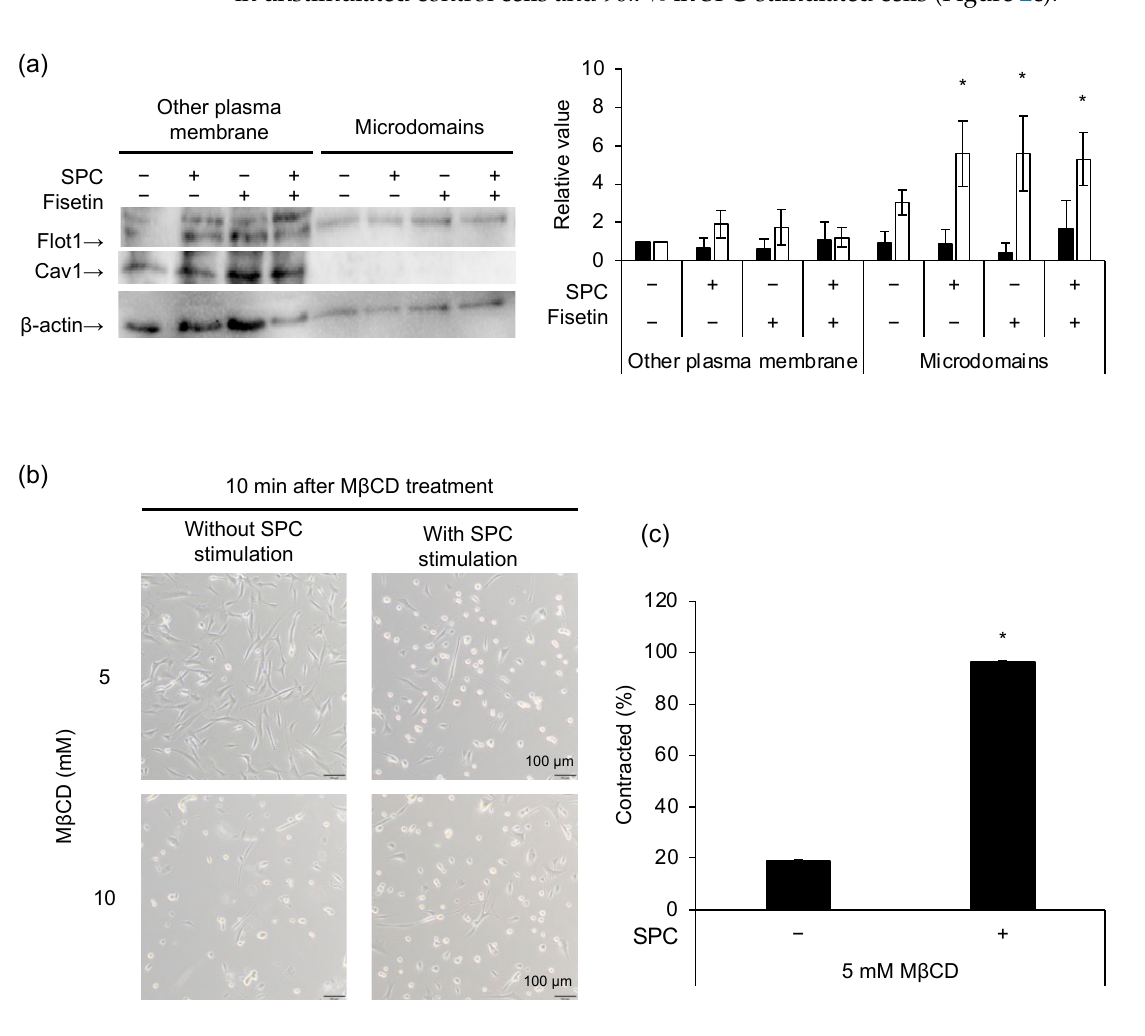
Figure 2. Analysis of sphingosylphosphorylcholine (SPC) and microdomain involvement in SPC- induced contractions of human coronary artery smooth muscle cells (HCASMCs). ( a ) Expression levels of the microdomain markers flotillin-1 (Flot1) and caveolin-1 (Cav1). Black and white indicate Cav1 and Flot1, respectively. ( b ) HCASMCs treated with 5 mM (top row) or 10 mM (bottom row) of methyl- β -cyclodextrin (M β CD). The left and right columns depict unstimulated and SPC-stimulated cells, respectively. ( c ) Contracted cell rates with microdomains disrupted by 5 mM of M β CD. * p < 0.05 vs. without SPC stimulation and fisetin treatment or only SPC stimulation. Data are represented as mean ± standard deviation.